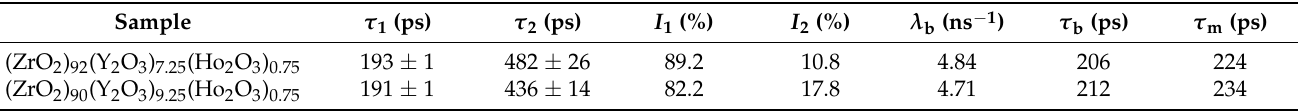
Table 2. Positronlifetimeparametersofthe(ZrO 2 ) 92 (Y 2 O 3 ) 7.25 (Ho 2 O 3 ) 0.75 and(ZrO 2 ) 90 (Y 2 O 3 ) 9.25 (Ho 2 O 3 ) 0.75